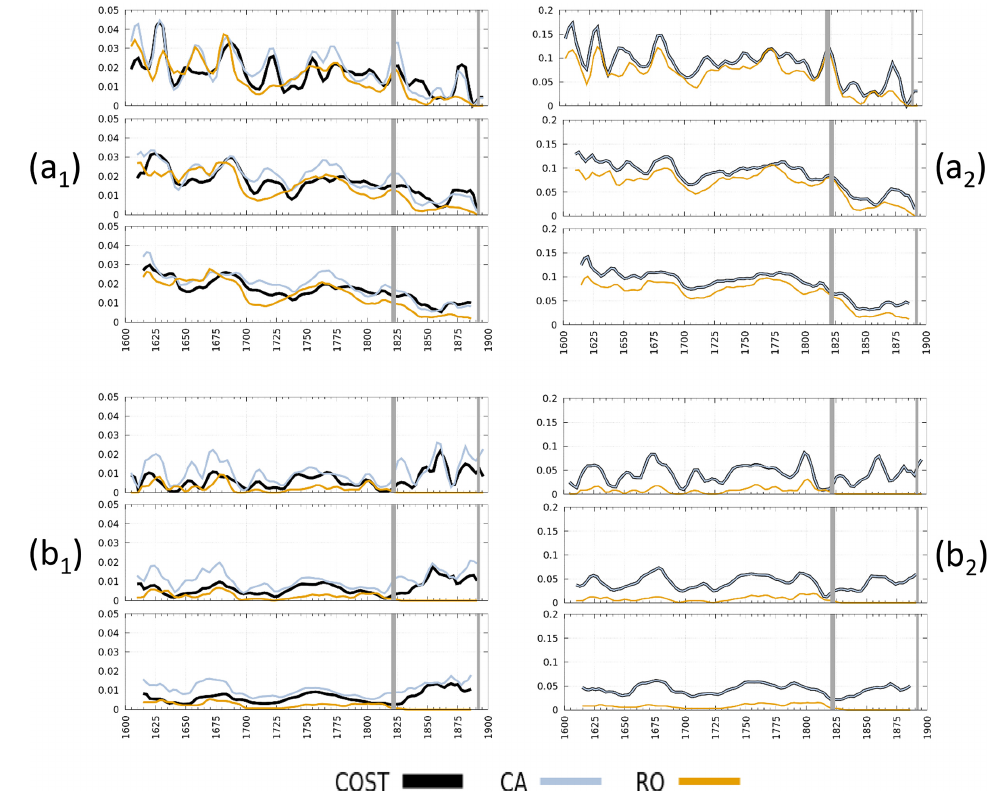
Figure 9. Normalised intensity and occurrence of droughts and extreme rainfall in Caravaca between 1600 and 1900. Series are normalised by dividing each datum by the maximum value of each series. Intensity is defined as the normalised monthly value, while occurrence is defined dichotomously by differentiating between the months when an event occurred (1) from the months with no event (0). Panel (a1) shows the running mean of drought intensity, while (a2) shows the running mean of droughts occurring. Panels (b1) and (b2) depict the same information but for extreme rainfall reconstruction. All the panels show the running mean with a temporal window of 10, 20 and 30 years, respectively. Note: data gaps (from 1820 to 1823 and 1891 to 1892) are shown in